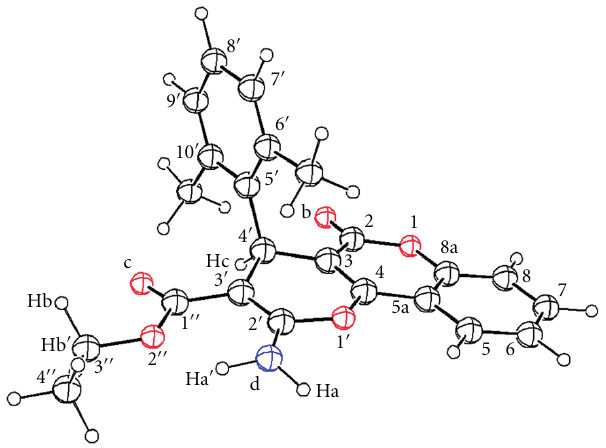
F 1: DFT/B3LYP optimized geometries of 5c .